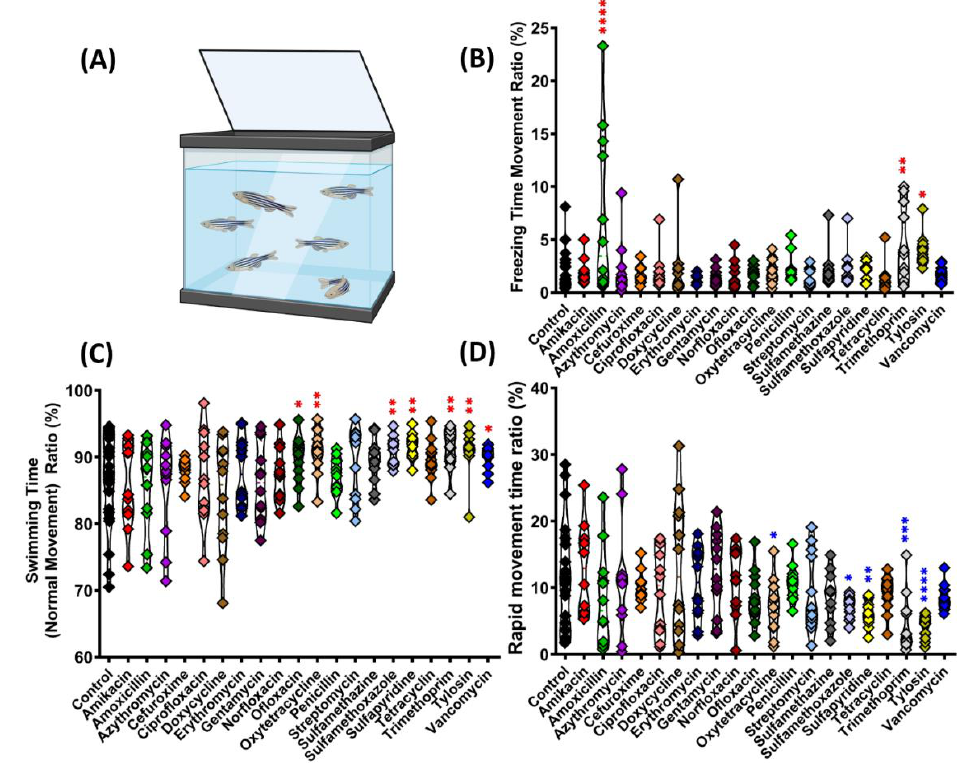
Figure 1. Comparison of swimming movement activity of golden zebrafish after 10 days exposure with different antibiotics in 3D locomotion test. ( A ) Outlooking of 3D locomotion testing tank; ( B ) freezing movement time ratio; ( C ) swimming time ratio; and ( D ) rapid movement time ratio. The data were analyzed by ordinary one-way ANOVA followed by Dunnett’s multiple comparison test ( n control: 24, n for each antibiotic group: 12). The significances were indicated by * p < 0.05; ** p < 0.01; *** p < 0.001; **** p < 0.0001 (red asterisk indicates a higher mean value, while blue asterisk indicates a lower mean value than the control).